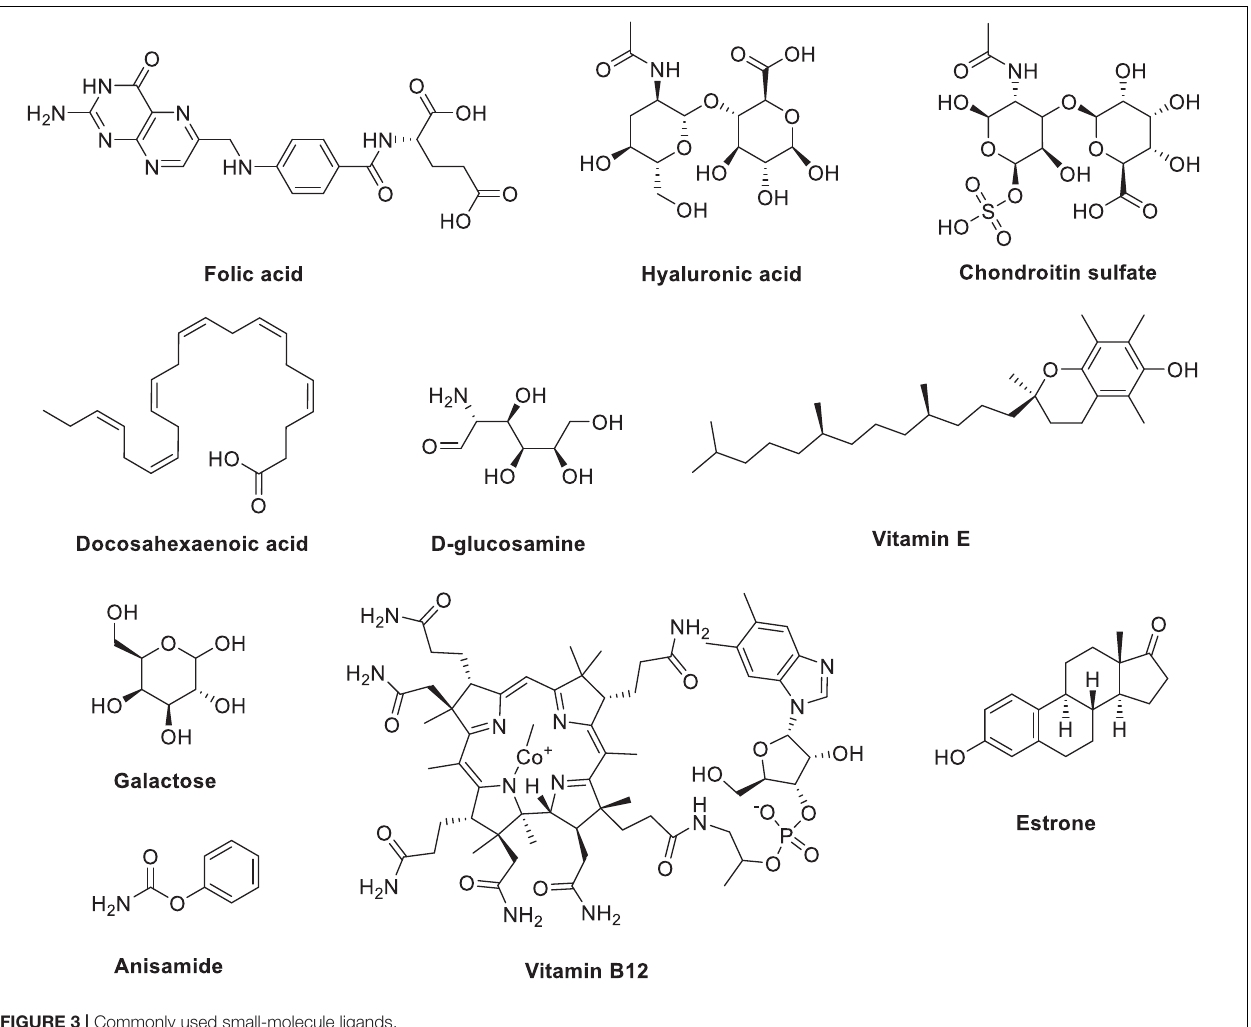
FIGURE 3 | Commonly used small-molecule